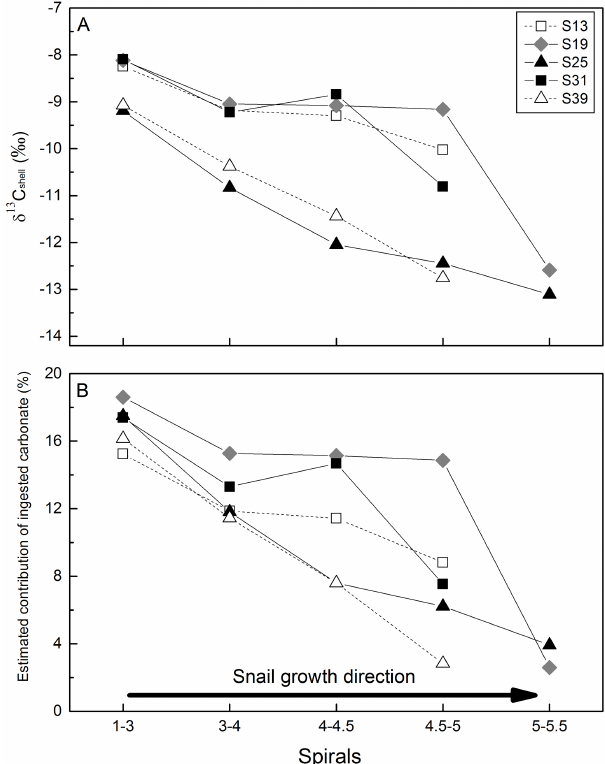
Figure 6. Bulk δ 13 C of snail shell aragonite and estimated contri- bution of ingested carbonate at different culturing conditions. Figure 7. δ 13 C of snail shell sections and their estimated contribu- tion of ingested carbonate at different growth